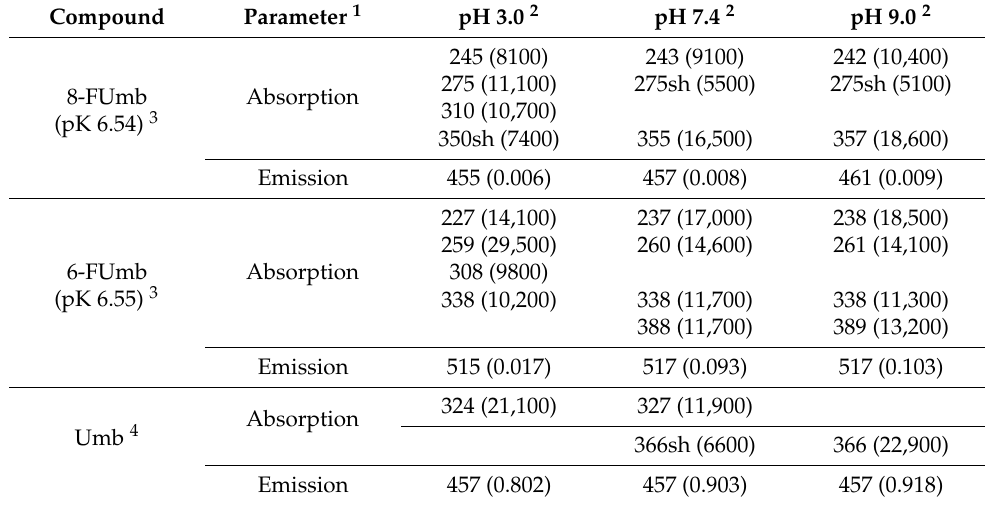
Table 3. Photophysical characteristics of ortho -formylated